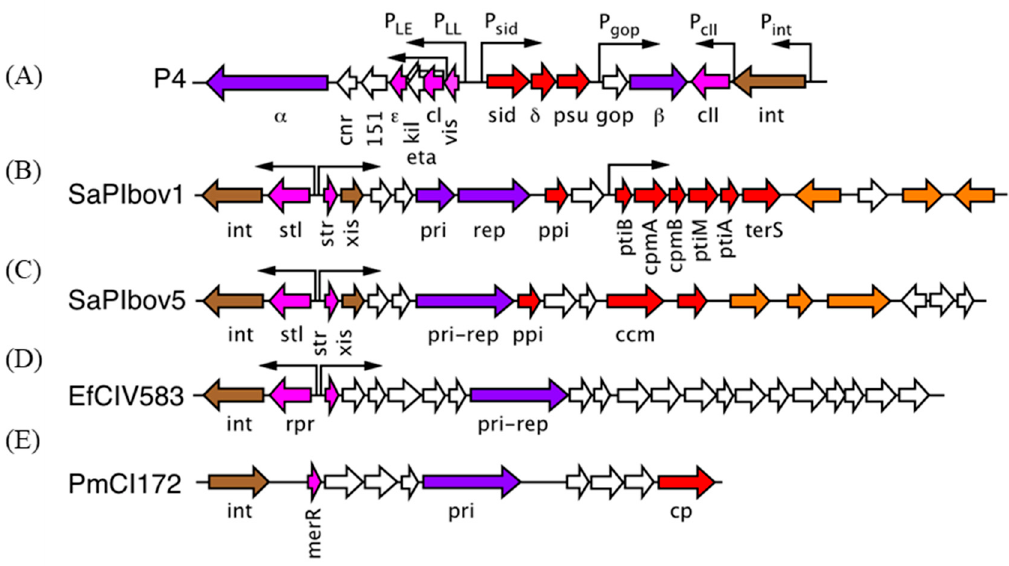
Figure 2. Genomes of pirate elements. ( A ) P4, ( B ) SaPIbov1, ( C ) SaPIbov5, ( D ) EfCIV583, ( E ) PmCI172. Color coding: genes involved in integration ( int ) and excision ( xis ), brown; replication-related genes (primase, replicase), purple; transcriptional regulators (repressors, activators), pink; genes demonstrated or presumed to be involved in helper exploitation (including capsid size redirection), red; virulence factor genes, orange. Other genes, white.